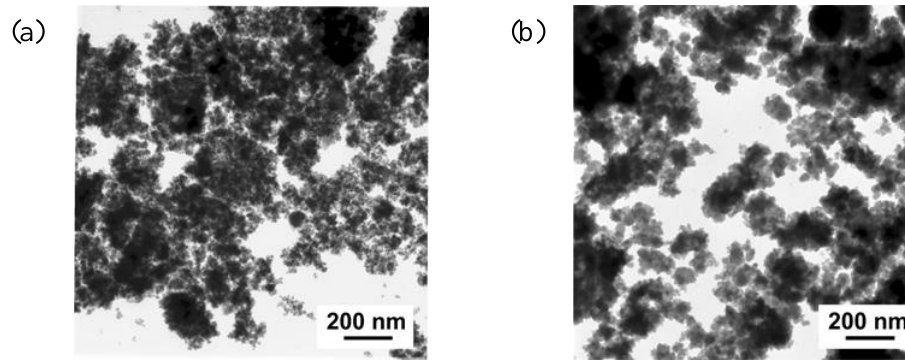
Figure 8. TEM microphotograph of unmodified SiO 20 parts by weight of POSS3 ( b ).